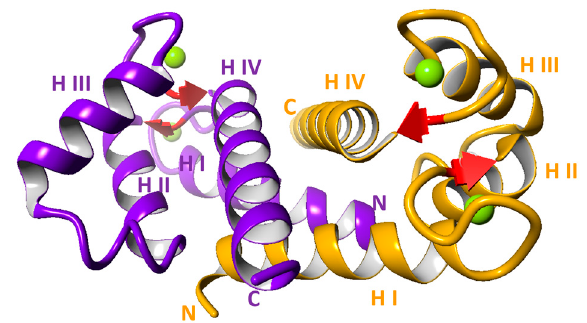
Figure 1. Structure of S100A6 dimer with 4 Ca 2+ (Protein Data Bank id:1K96) [10]. Each monomer is represented by different color (violet and yellow); green balls represent Ca 2+ ; H indicates helix; N and C indicate N- and C-terminus, respectively.